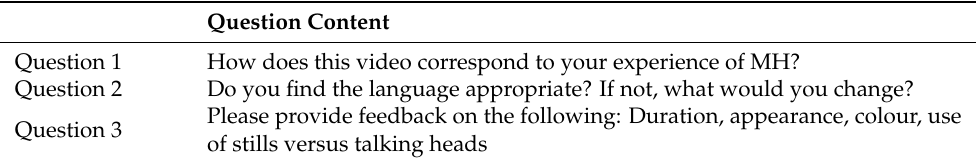
Table A2. Focus group and interview round 2